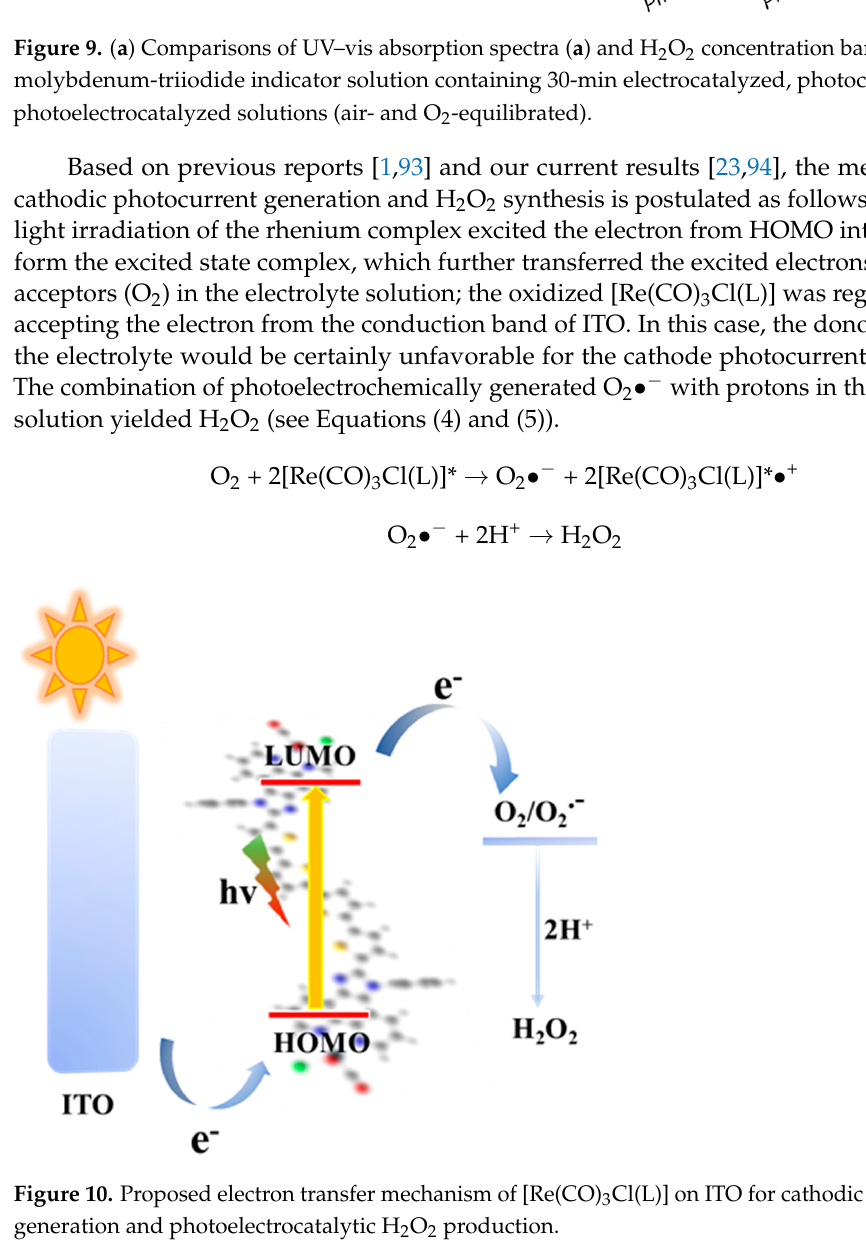
Figure 9. ( a ) Comparisons of UV–vis absorption spectra ( a ) and H 2 O 2 concentration bar charts ( b ) of molybdenum-triiodide indicator solution containing 30-min electrocatalyzed, photocatalyzed and photoelectrocatalyzed solutions (air- and O 2 -equilibrated).